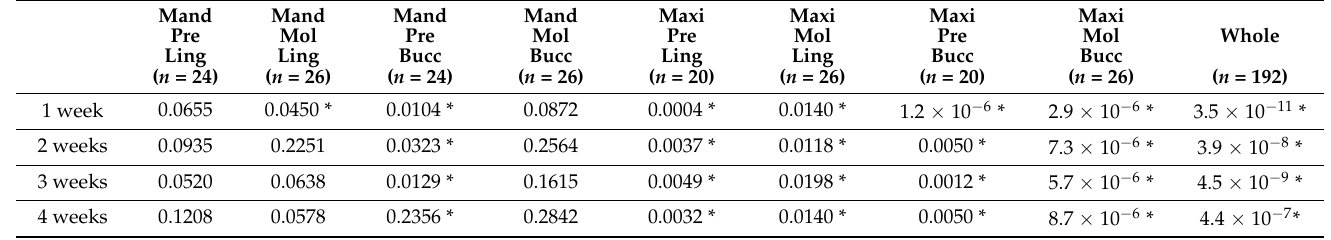
Table 6. p -values comparing the adhesion ratio of Bio Coat Ca and Hybrid Coat II in eight sections.